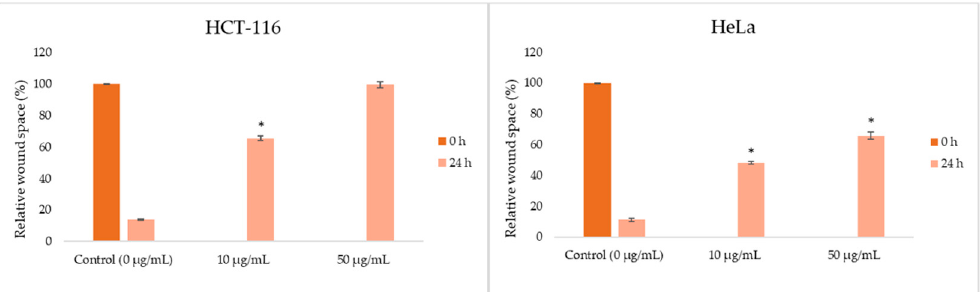
Figure 3. Suppression of HCT ‐ 116 and HeLa cells motility by LSEA extract measured after 0 and 24 h of treatment.